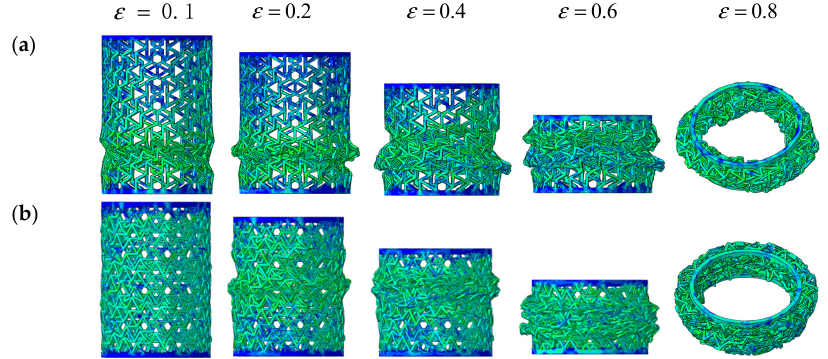
Figure 16. The deformation process of composite RHCSs when V = 10 m/s: ( a ) [30°/ − 30°] RHCS; ( b ) [60°/ − 60°] RHCS.